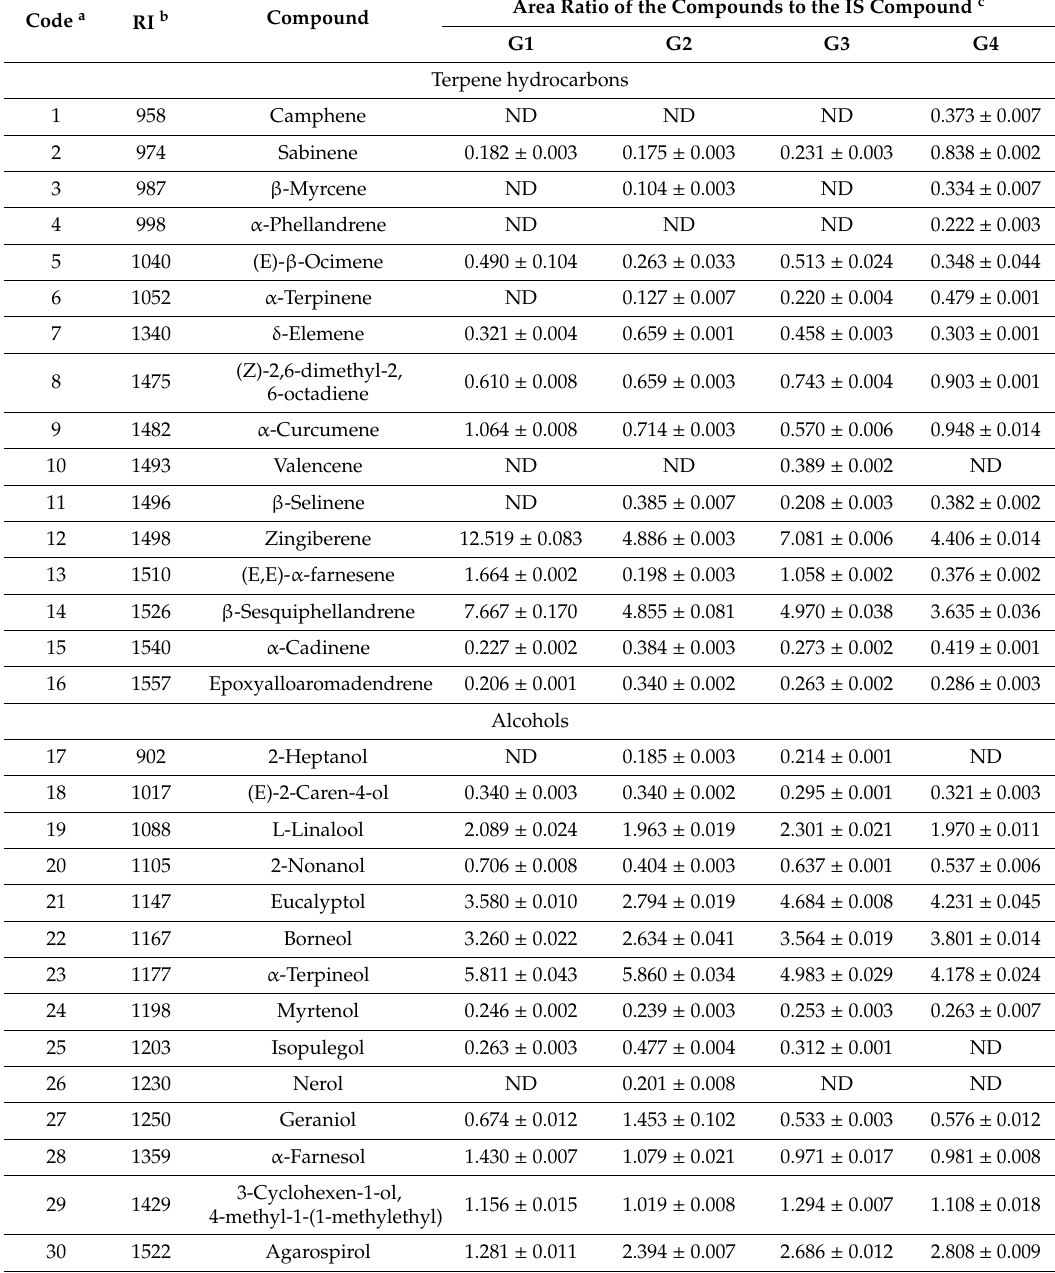
Table 6. Concentration of volatile compounds detected in four di ff erent ginger flavored